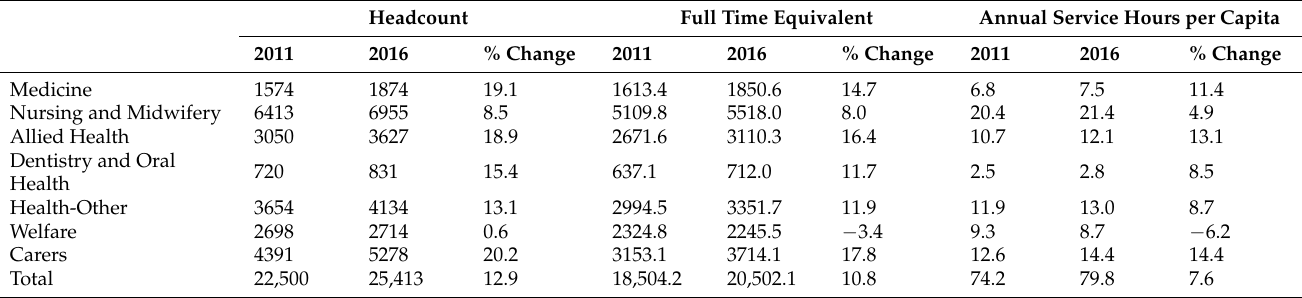
Table 1. Changes in the Tasmanian health, welfare and care workforce between 2011 and